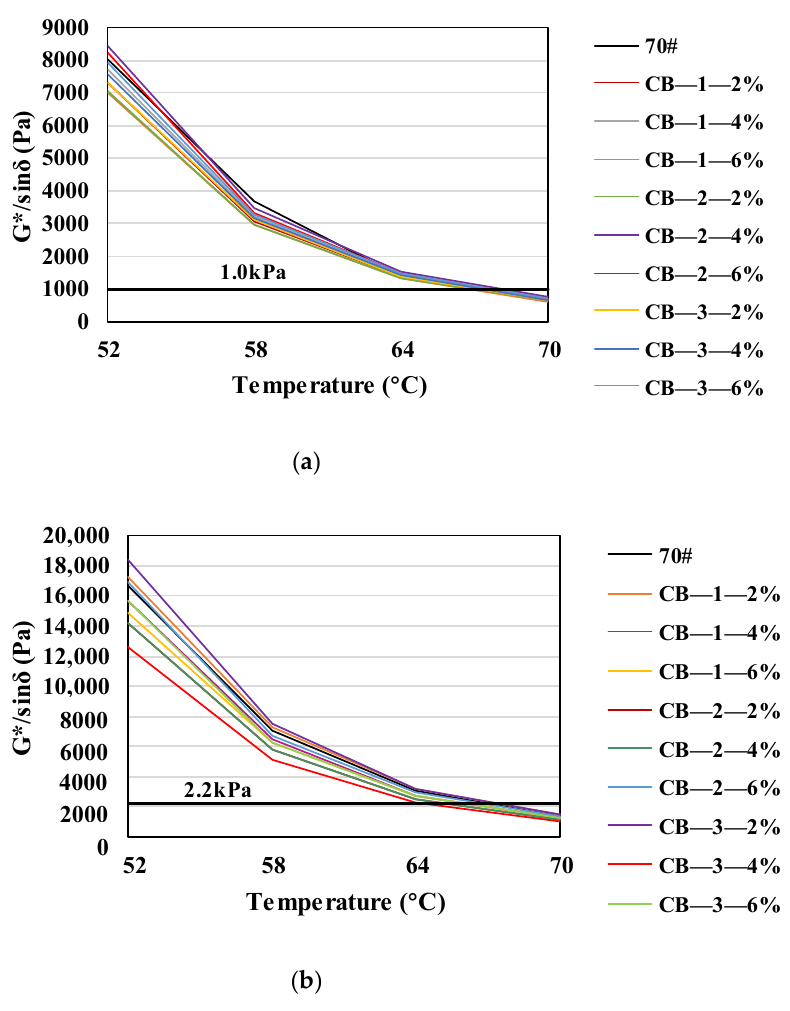
Figure 3. Results of temperature scanning tests: ( a ) virgin asphalt; ( b ) asphalt after TFOT aging. It can be seen from Figure 3 that for all 10 asphalt specimens, the PG high temperature grade is 64 ◦ C. In Superpave specification, the rutting factor G*/sin δ represents the anti- deformation performance of asphalt binder, and the rutting factors of 10 unaged asphalt specimens at 64 ◦ C were compared, as shown in Figure 4.